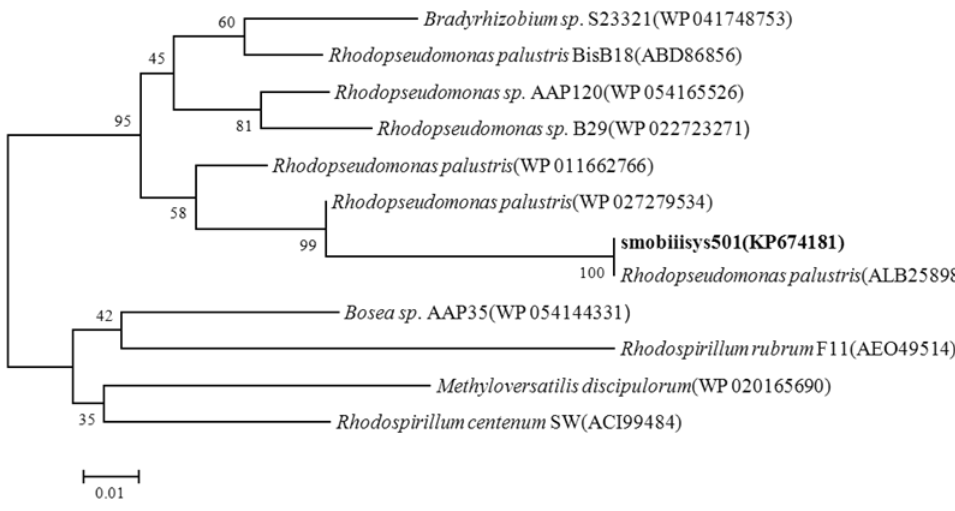
Figure 3. Phylogenetic tree of the strain Smobiisys501 based on the BchY protein homology.